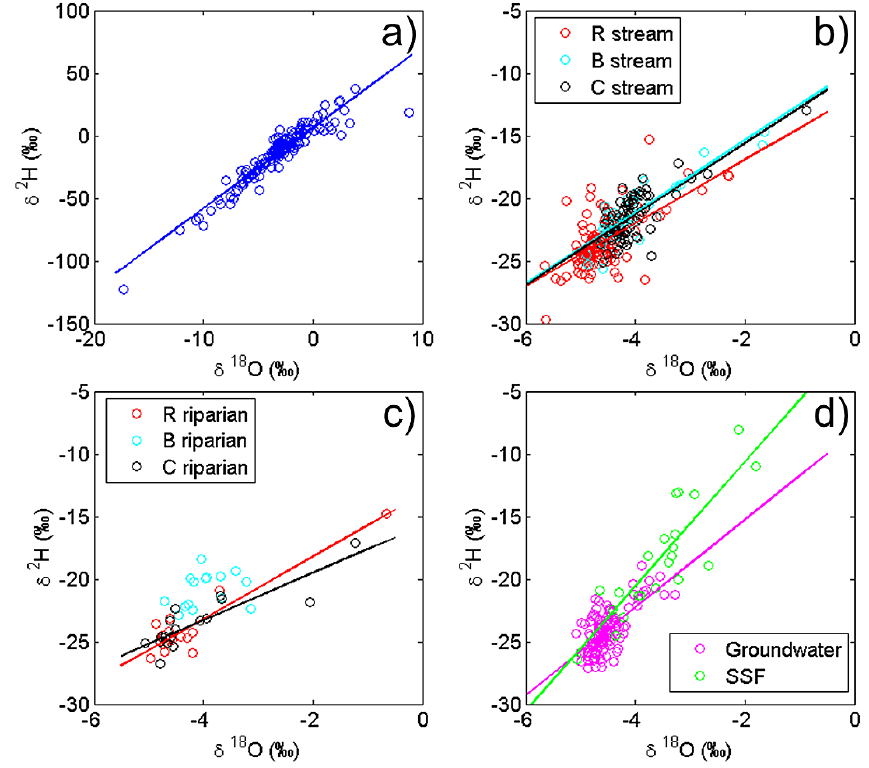
Figure 4. 2 H versus 18 O and the meteoric and evaporation water lines for (a) precipitation, (b) streamflow of the three streams, (c) the groundwater in the riparian piezometers in each watershed, and (d) subsurface stormflow in the R watershed and groundwater. Note the different x and y axes in panel (a) vs. panels (b–d)